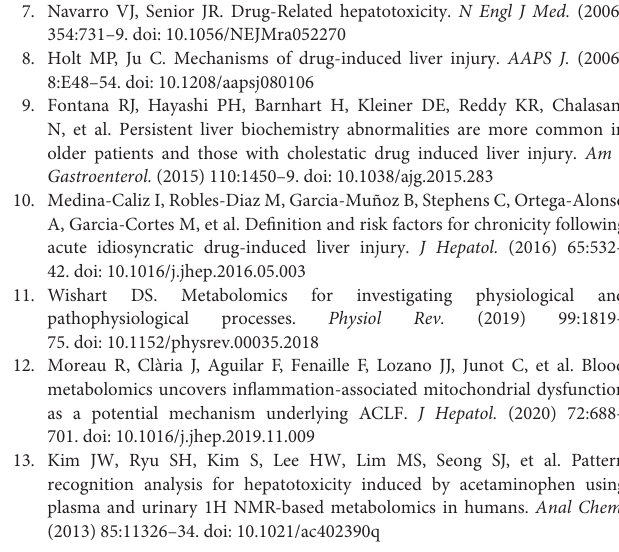
Supplementary Figure 1 | Histological and demographic information comparison with cirrhosis and decompensation associated fingerprints. (A,B) Cirrhosis and decompensation associated fingerprints were positively correlated with fibrosis stage in liver biopsy. (C,D) Cirrhosis and decompensation associated fingerprints did not show significantly statistical difference on age and sex. S, fibrosis stage. Supplementary Table 1 | The detailed information about 30 metabolites in metabolic fingerprint for cirrhosis. Supplementary Table 2 | The detailed information about 25 metabolites in metabolic fingerprint for decompensation. Supplementary Table 3 | Metabolites whose difference may affect the clinical phenotypes on cirrhosis and